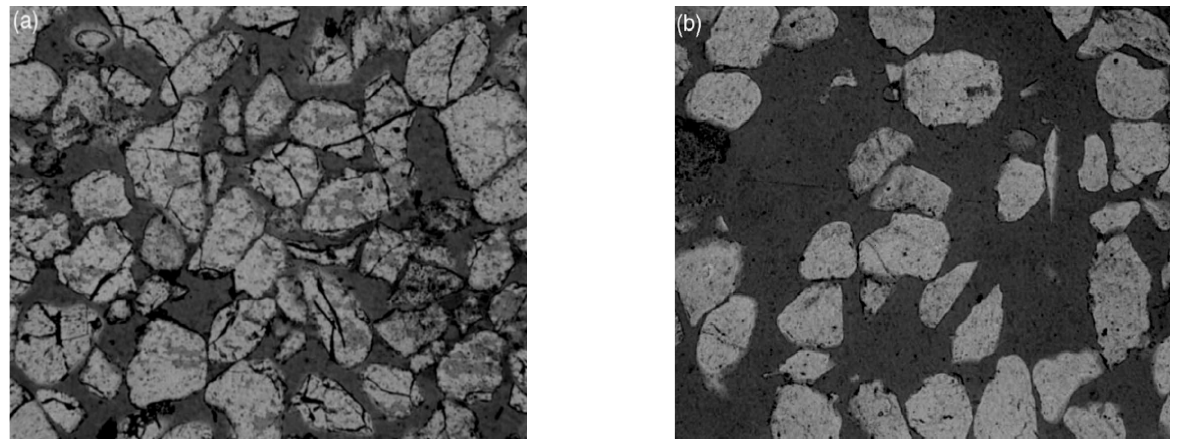
Figure 6. ( a ) Rock micrograph before dilatancy. ( b ) Rock micrograph after